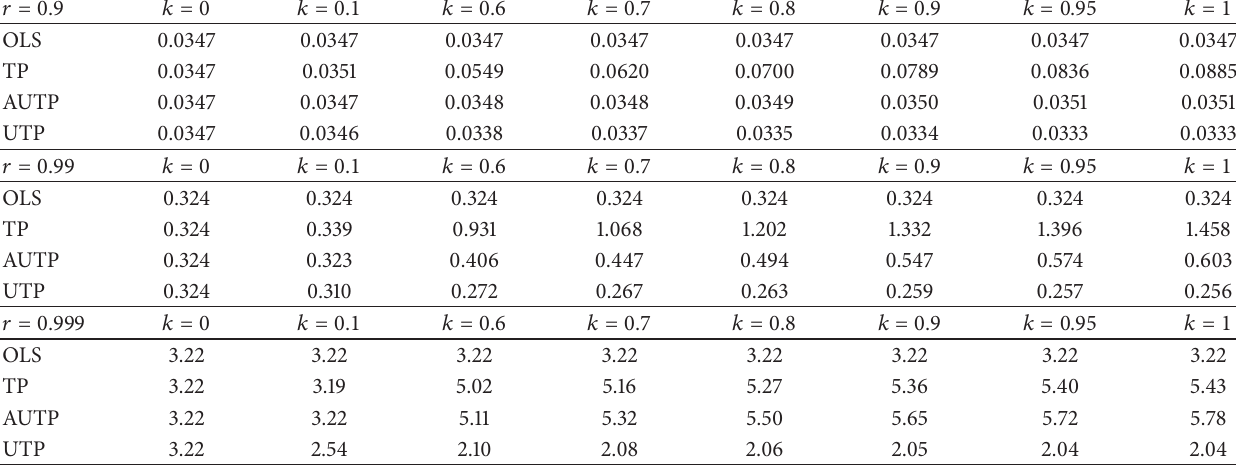
Table 3: Estimated MSE values of OLS, TP, AUTP, and UTP when 𝑛 = 50 , 𝑝 = 4 , and 𝜎 2 = 0.1